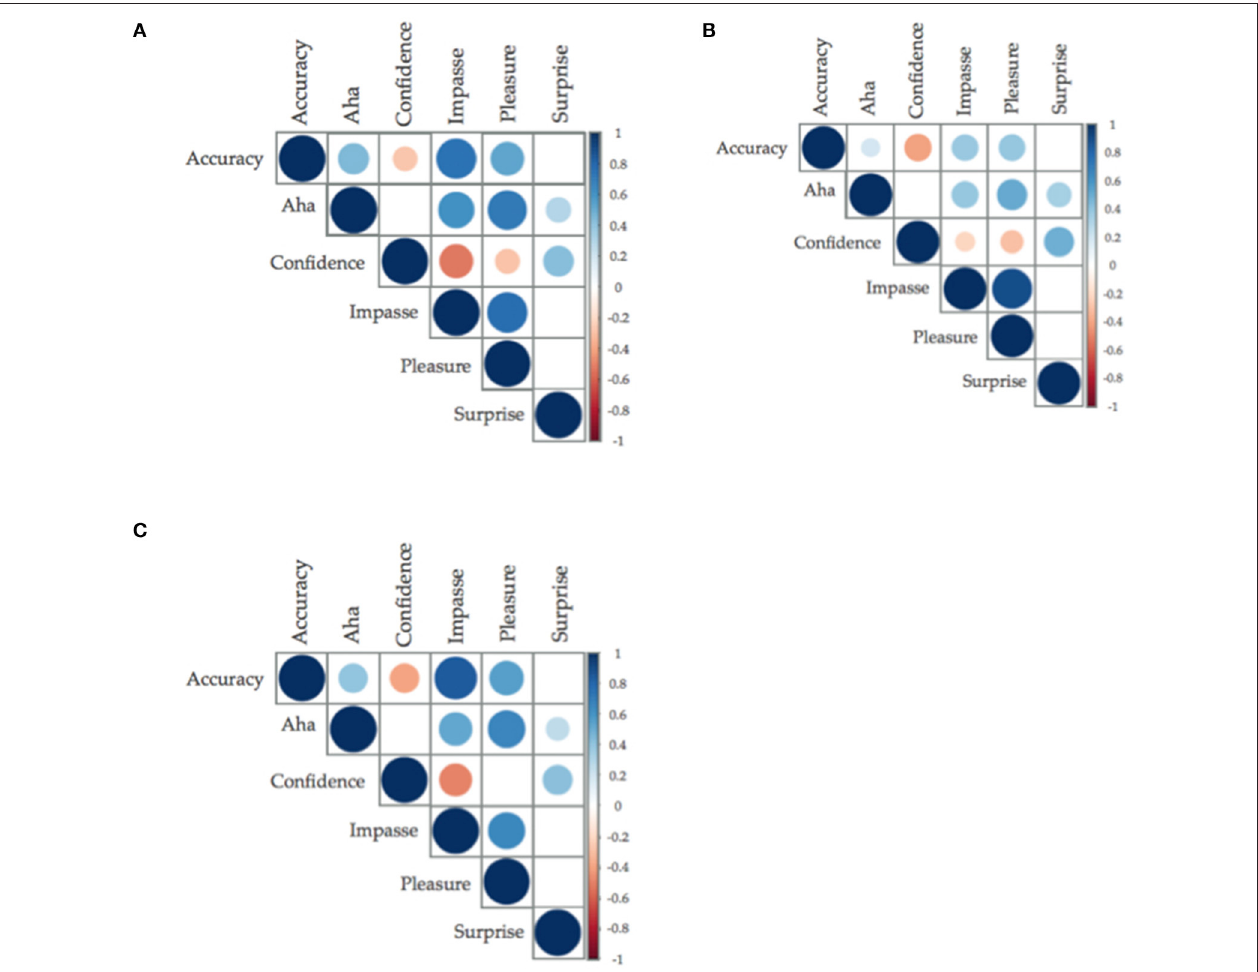
FIGURE 4 | (A–C) Correlation plots between accuracy and insight and insight related affect (only data from before performance feedback was graphed). Size of the circle and saturation of color determine the strength of the correlation; the color determined the direction of the relationship, with positive being blue ( A : Classic insight problems; B : classic non-insight problems; C : compound remote associates. Only relationships with less than p = 0.05 have been graphed).